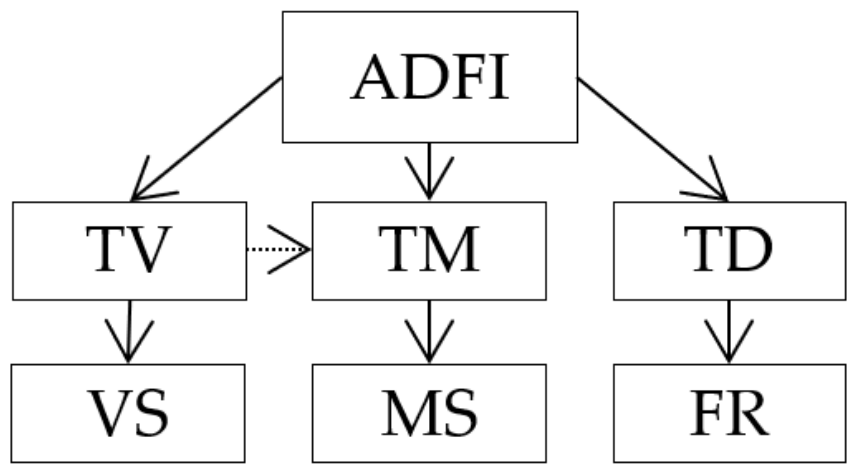
Figure 1. Interrelations of the feeding behaviour habits (FBHs). Average daily feed intake (ADFI), number of feeder visits per pig and day (TV), number of meals per pig and day (TM), total minutes spent eating per pig and day (TD), feed consumed per feeder visit (VS), feed consumed per meal (MS), and feed intake per minute spent eating (FR).